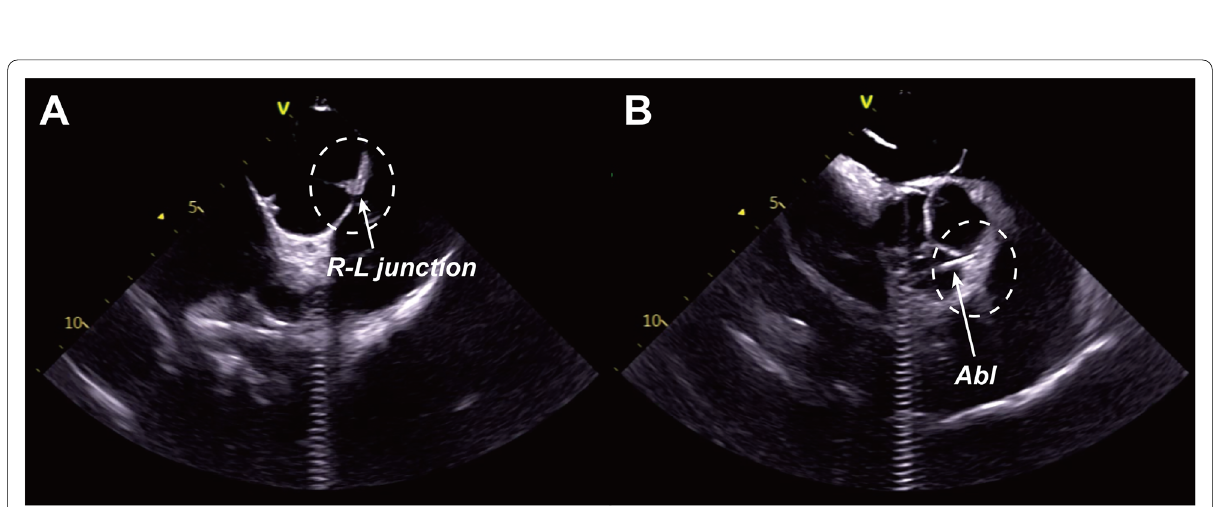
Fig. 4 Assessment of effective lesion formation using intracardiac echocardiography. A . Before ablation. B . During ablation at RCC‑LCC junction (dashed line). Increased echogenicity was observed during ablation compared with before ablation. R‑L, right coronary cusp‑left coronary cusp; Abl, ablation